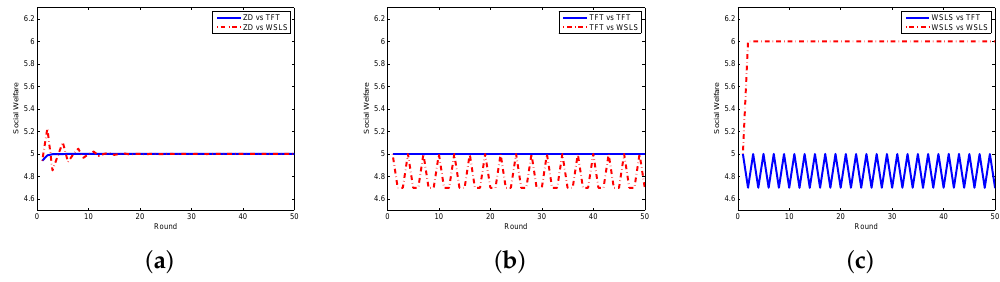
Figure 3. Social welfare with different strategy pairs (requestor vs. worker) among ZD, TFT, and WSLS in the discrete model. ( a ) requestor adopts the ZD strategy; ( b ) requestor adopts the TFT strategy; and ( c ) requestor adopts the WSLS